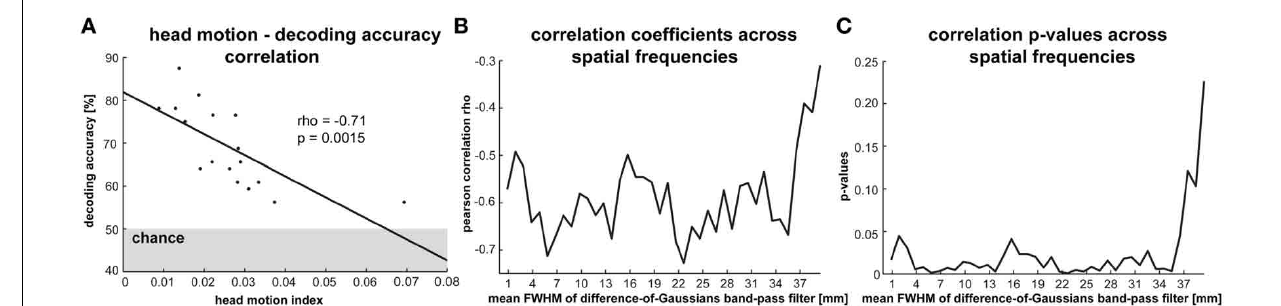
FIGURE 6 | Impact of head motion on orientation decodability. (A) The correlation between a head motion index—reflecting the average translation and rotation changes per volume/2s—and average orientation classification performance (averaged across all stimulus types) across participants. There are 17 data points because we excluded one participant whose average head